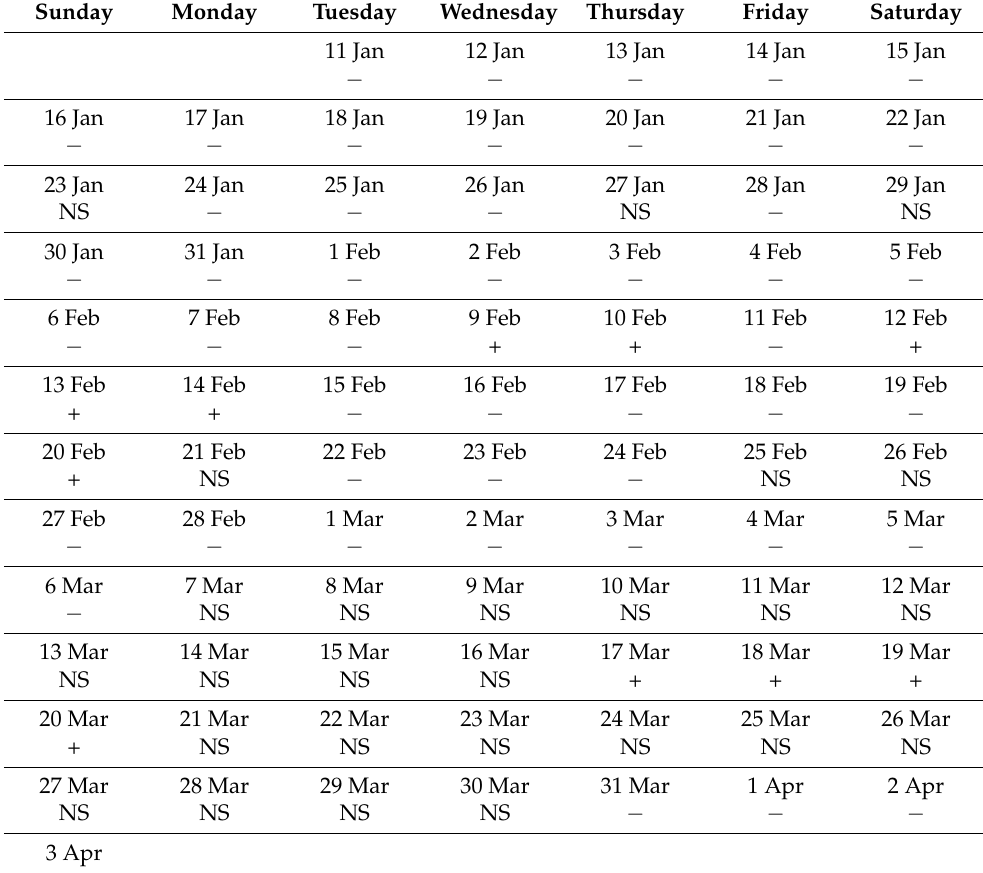
Table 1. Detection of SARS-CoV-2 in the Liquid Fraction of Wastewater in 2022.